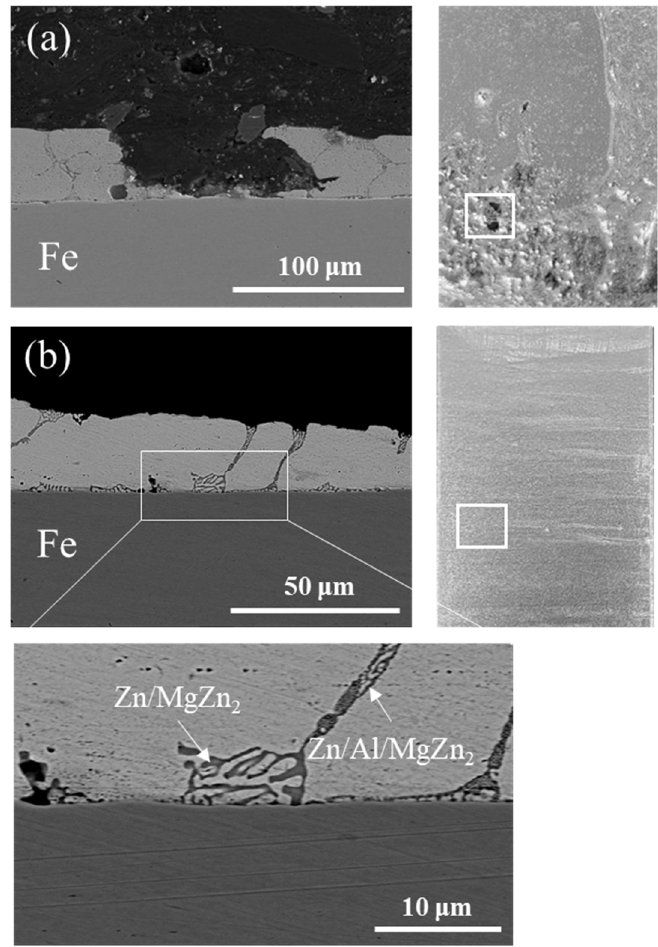
Figure 2. Cross ‐ sectional images of (a) NF and (b) SF30 samples. Figure 2. Cross-sectional images of ( a ) NF and ( b ) SF30